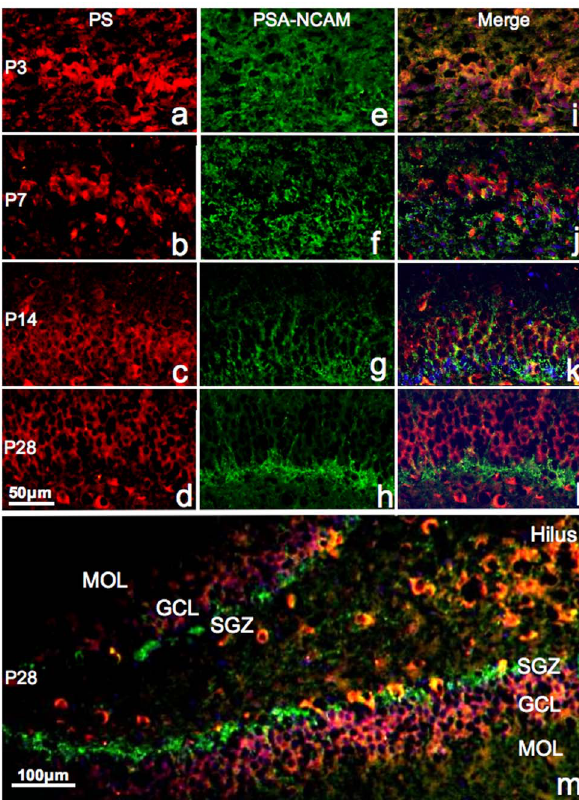
Figure 2. Fluorescent immunoreactivity of PS and PSA-NCAM. Fluorescent micrographs of the upper blade of the dentate gyrus showing immunoreactivity of PS (red, a–d ), PSA-NCAM (green, e–h ), and their merge ( i–l ) at P3 ( a , e , i ), P7 ( b , f , j ), P14 ( c , g , k ), and P28 ( d , h , l ). Nuclei are stained with DAPI (blue). Note that some double-positive cells were observed at P14 ( k ), and prosaposin-negative and PSA- NCAM-positive neurons clearly localized in the SGZ at P28 ( d , h , l ). A low power image of dentate gyrus double-stained with PSA-NCAM and PS at P28 is shown in panel m . MOL: molecular layer, GCL: ganglion cell layer, SGZ: subgranular zone.